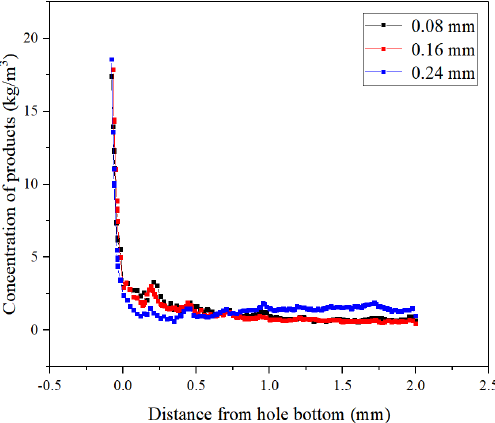
Figure 12. Concentration contours of processing products in machining gap using trapezoidal helical electrodes with different helical groove depths: ( a ) 0.08 mm; ( b ) 0.16 mm; and ( c ) 0.24 mm.